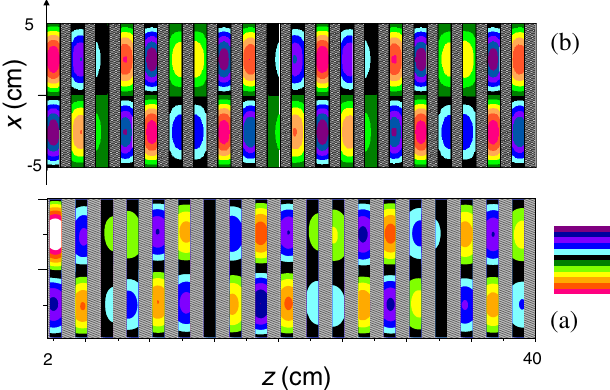
FIG. 9. (a) Simulated contour plot of B in the x - z plane ( y ¼ x (cid:1) 1 mm ) at fixed time, generated by a current driver operating at 5.3 GHz in the lowest antisymmetric mode. (b) Theoretical in the x - z plane ( y ¼ (cid:1) 0 mm ) at fixed contour plot of B x time, corresponding to the forward wave. The time has been chosen to maximize resemblance, and the overall scale has been freely adjusted.